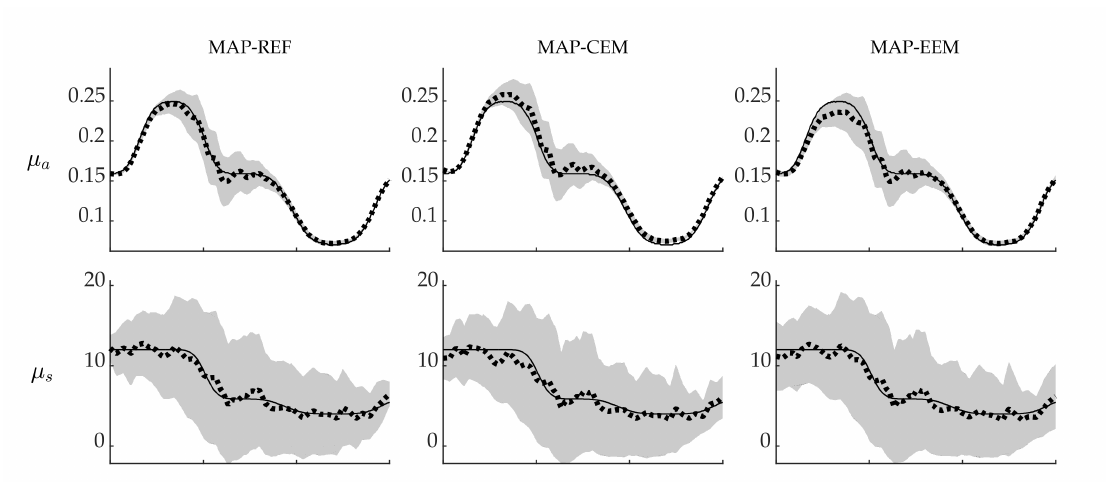
Figure 3. Gaussian approximations of the posterior distributions of the simulations with smooth inclusions along the cross-section shown in Figure 1. MAP-REF reconstructions ( first column ), MAP-CEM reconstructions ( second column ) and MAP-EEM reconstructions ( third column ). Solid line is the true value along the cross-section, dotted line is the MAP estimate and gray area covers the credibility interval [ ˆ µ − 3 σ ˆ µ , ˆ µ + 3 σ ˆ µ ] . The first row presents the absorption µ a ( mm − 1 ) and the second row the scattering µ s ( mm − 1 ) .